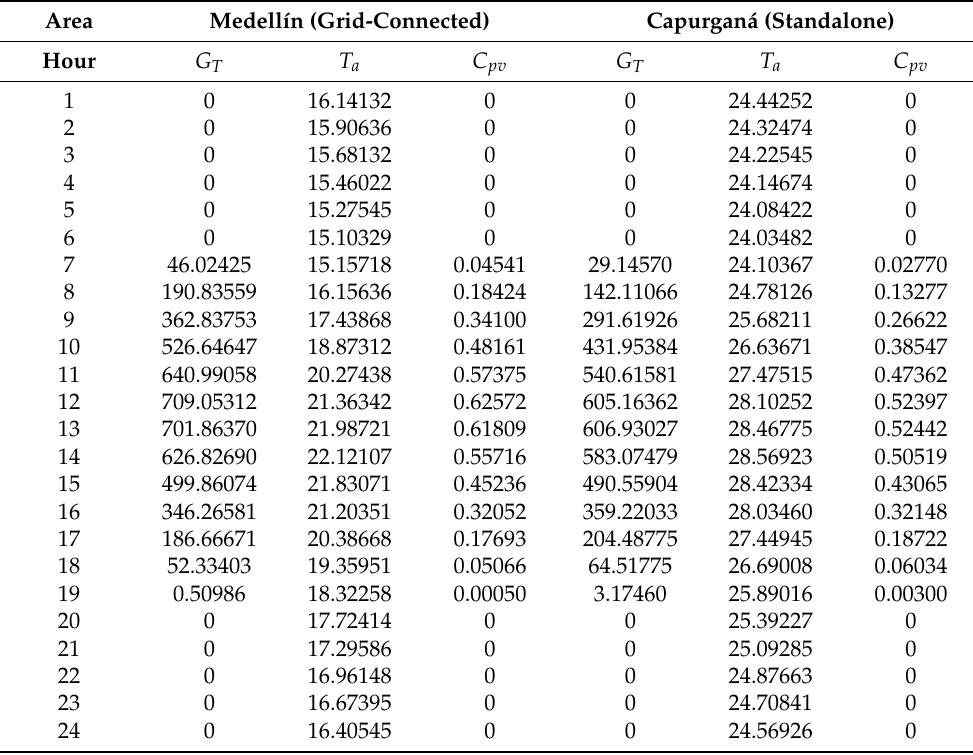
Table 5. Solar radiation data (W/m 2 ), ambient temperature ( ◦ C), and behavior (p.u.) for an average day in the areas under study.